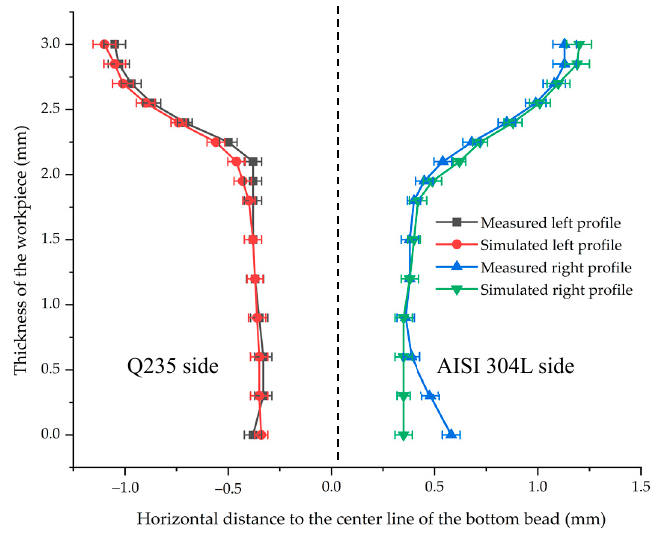
Figure 5. Comparison of the experimental and simulation results: ( a ) top view of the experimental result; ( b ) cross-section view of the experimental result; ( c ) top view of the simulation result; ( d ) cross-section view of the simulation result.